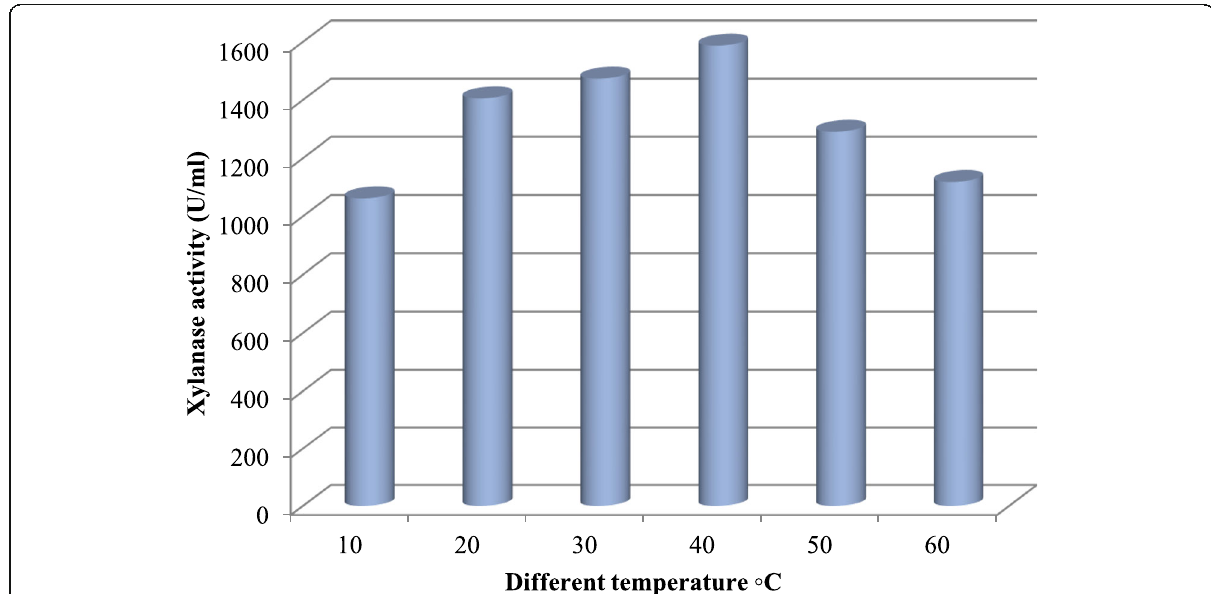
Fig. 8 Effect of different temperature °C on crude xylanase